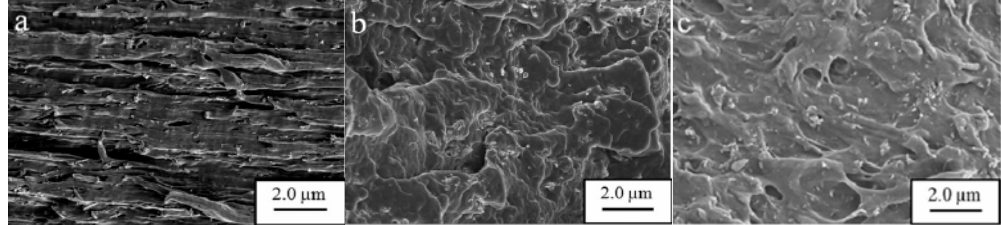
Figure 8. SEM images of fractured surfaces of PVA-HNT films after different H 2 SO 4 treatment times